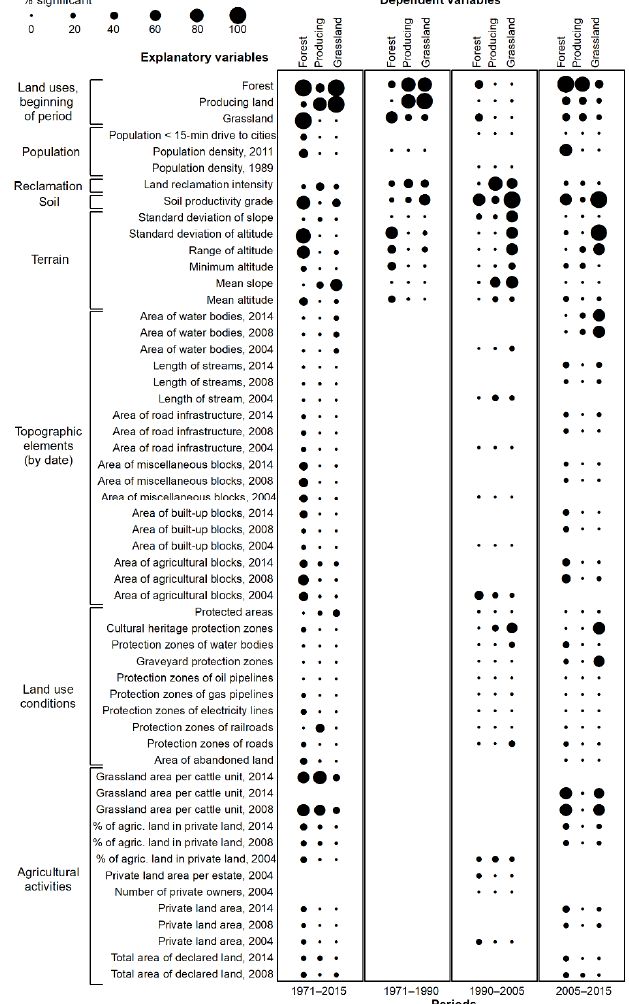
Figure 5. The proportions of times that each candidate explanatory variable was statistically signif- icant when testing all potential regression models. Blank means that the variable was not included in the exploratory regression runs.